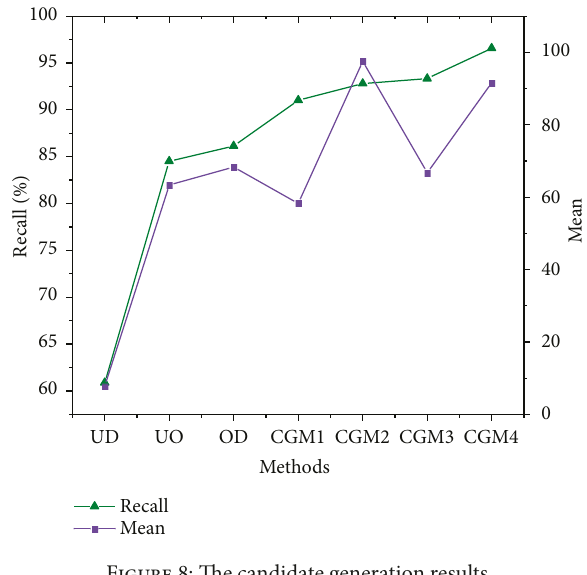
Figure 8: The candidate generation